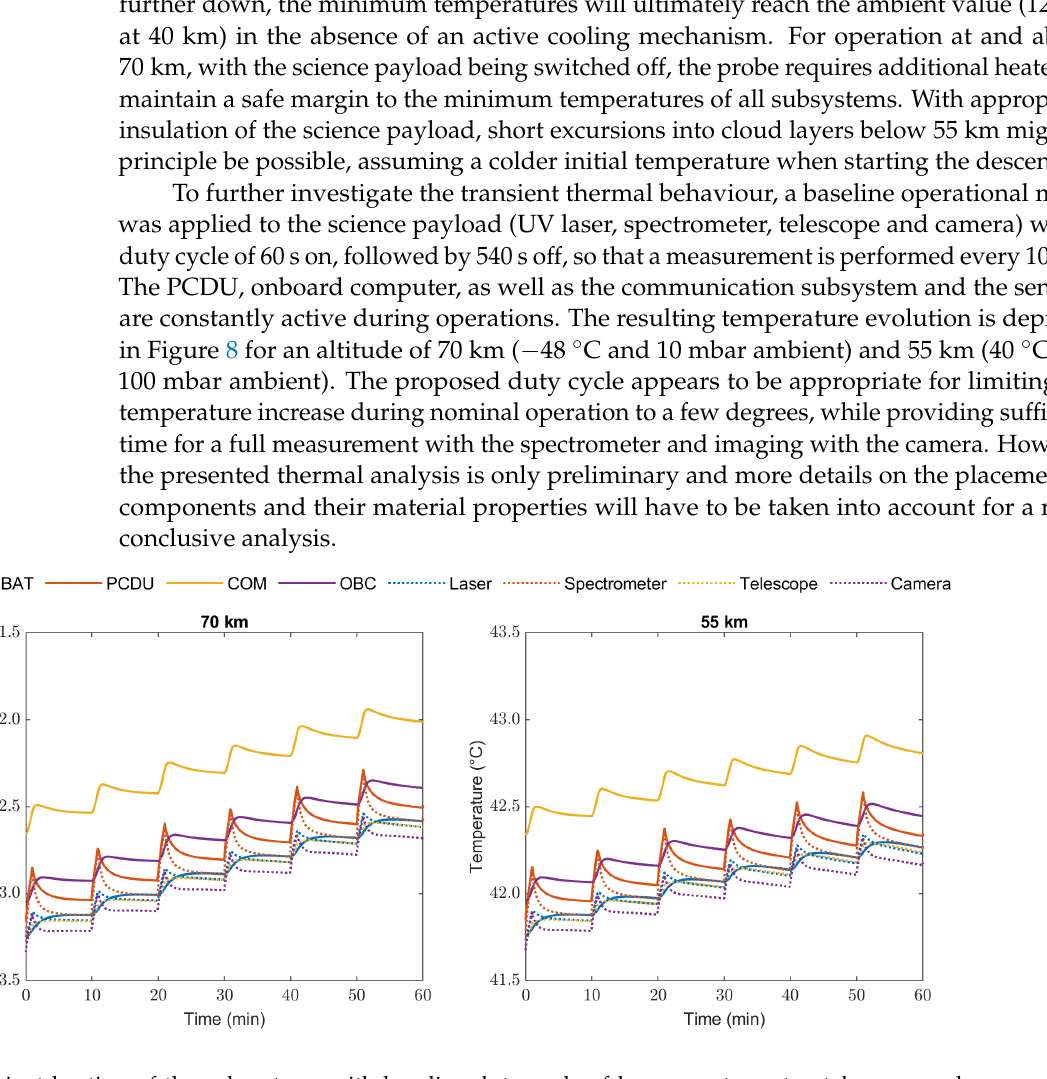
Figure 8. Transient heating of the subsystems with baseline duty cycle of laser, spectrometer, telescope and camera. The initial temperature equals the steady state temperatures with the aforementioned components switched